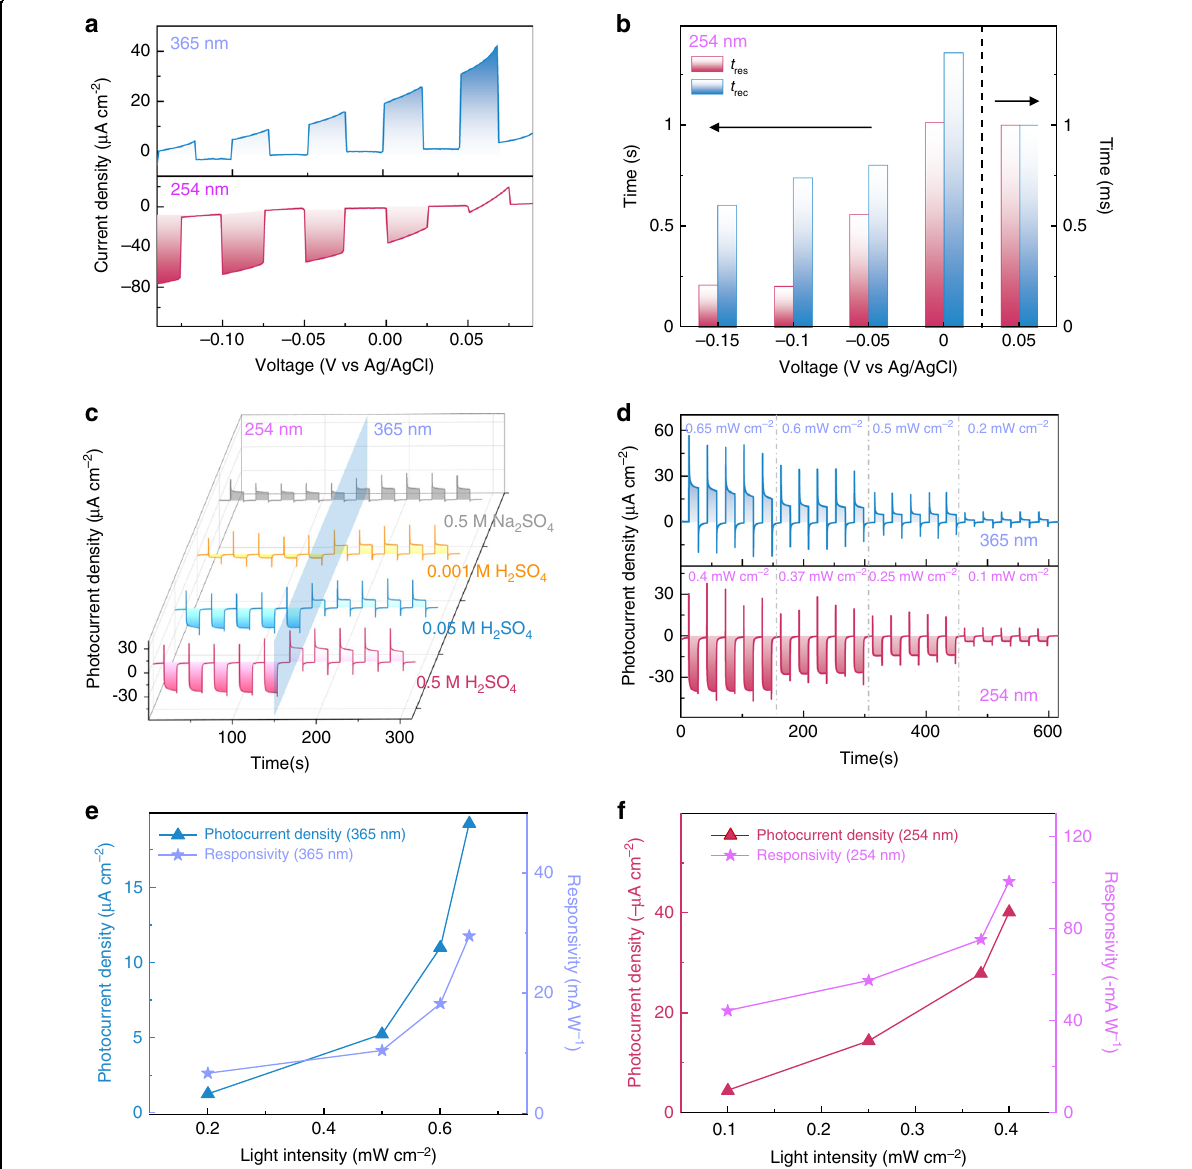
Fig. 4 Spectrally distinctive photodetection. a LSV curves of a-MoS x @p-AlGaN/n-GaN nanowires with potential varied from 0.1 to − 0.15 V in 0.5 M H 2 SO 4 . Scan rate is 2.5 mV/s. b The bias dependent photoresponse behavior of a-MoSx@p-AlGaN/n-GaN nanowires at 254 nm illumination. c I photo − t characteristics of a-MoS x @p-AlGaN/n-GaN nanowires in different concentration of H 2 SO 4 (0.001, 0.05, 0.5 M) and 0.5 M Na 2 SO 4 at 0 V. d Photoresponse behavior of the a-MoS x @p-AlGaN/n-GaN nanowires photodetector under 365 nm (top) and 254 nm (bottom) wavelength light illumination with different light intensities. The photocurrent density and corresponding calculated photoresponsivity of a-MoS x @p-AlGaN/n-GaN nanowires under various power intensities of e 365 nm and f 254 nm illumination. The photocurrent density and responsivity of 365 nm is positive, while the photocurrent density and responsivity of 254 nm is